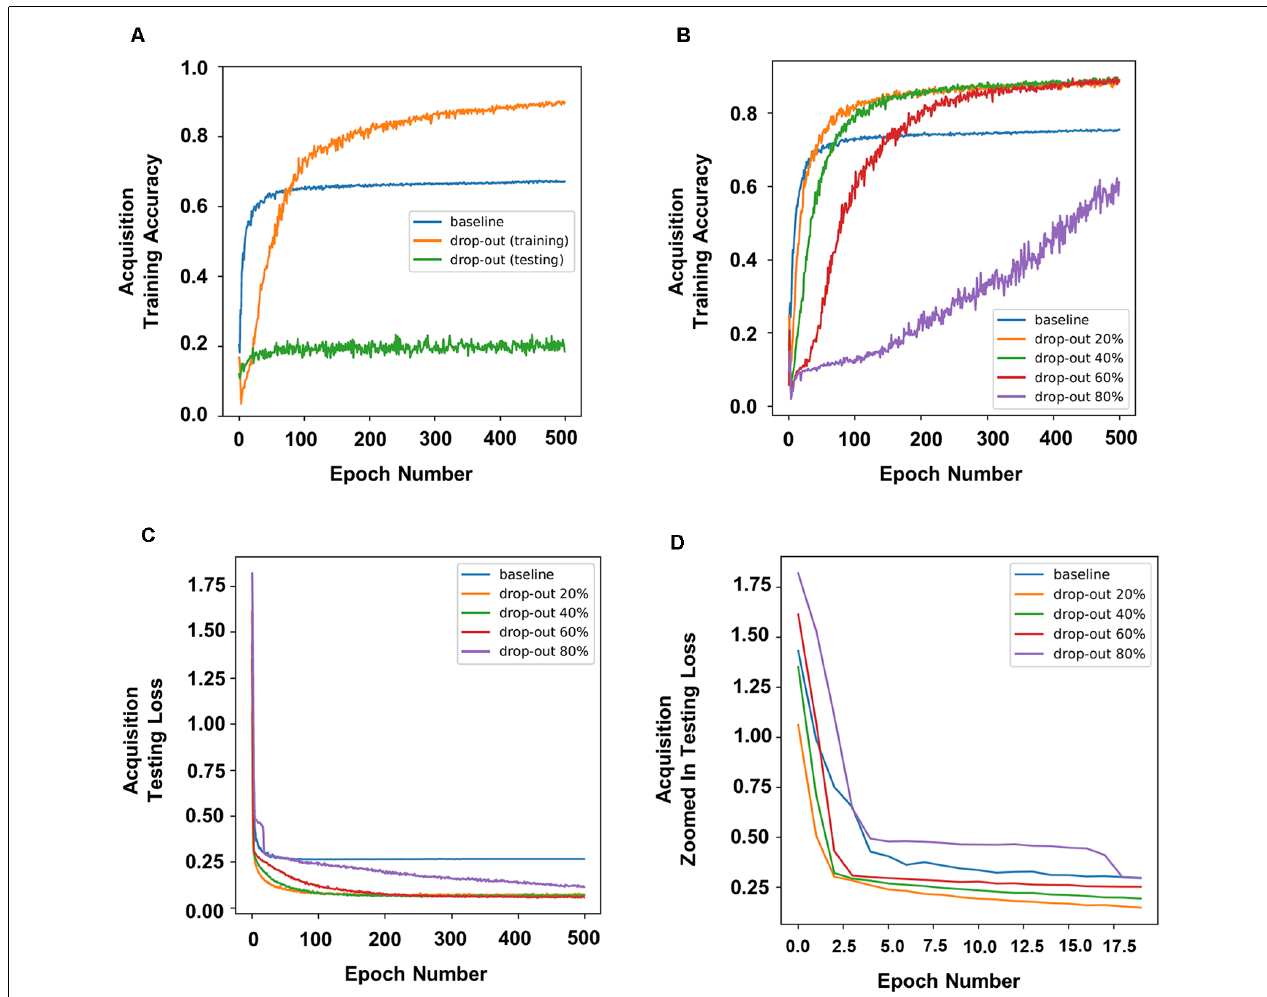
FIGURE 2 | Dropout in neural nodes disrupted or enhanced learning in the neural networks depending on when it was applied. Dropout applied during training improved prediction accuracy, whereas dropout applied during testing dramatically decreased prediction accuracy (A) . (B) Prediction accuracy of different rates of dropout during training. (C) The training loss and (D) a zoomed in version of the first 20 epochs in panel (C)